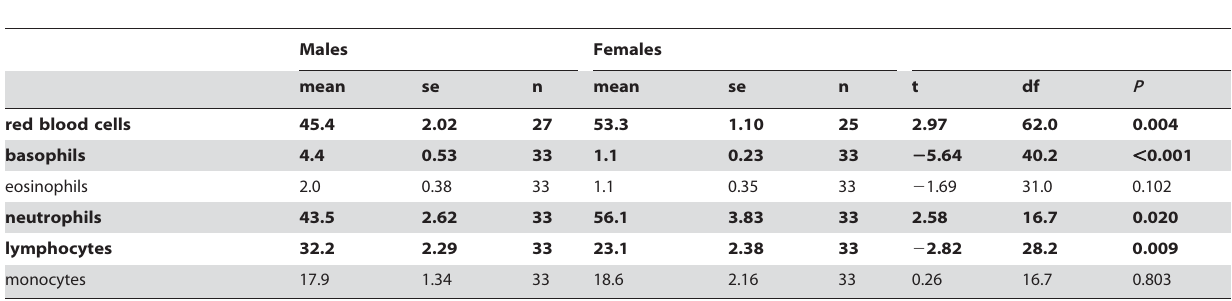
Table 1. Average blood cell percentages for male and female Xerus inauris (significant differences indicated by bold text).